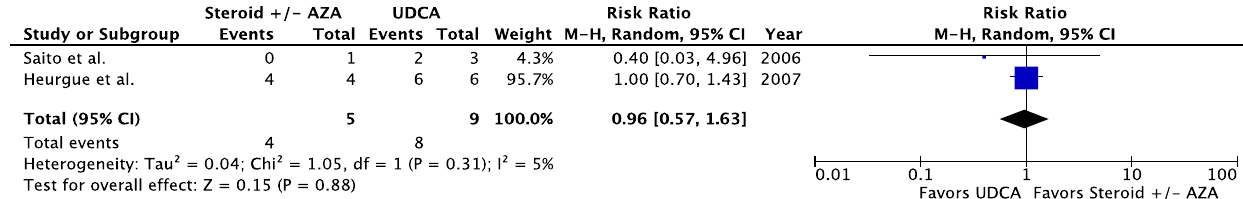
Figure 6. Transplant-free survival in AIH-PBC patients treated with immunosuppression vs. UDCA. UDCA = ursodeoxycholic acid, steroid = corticosteroids, AZA = azathioprine.